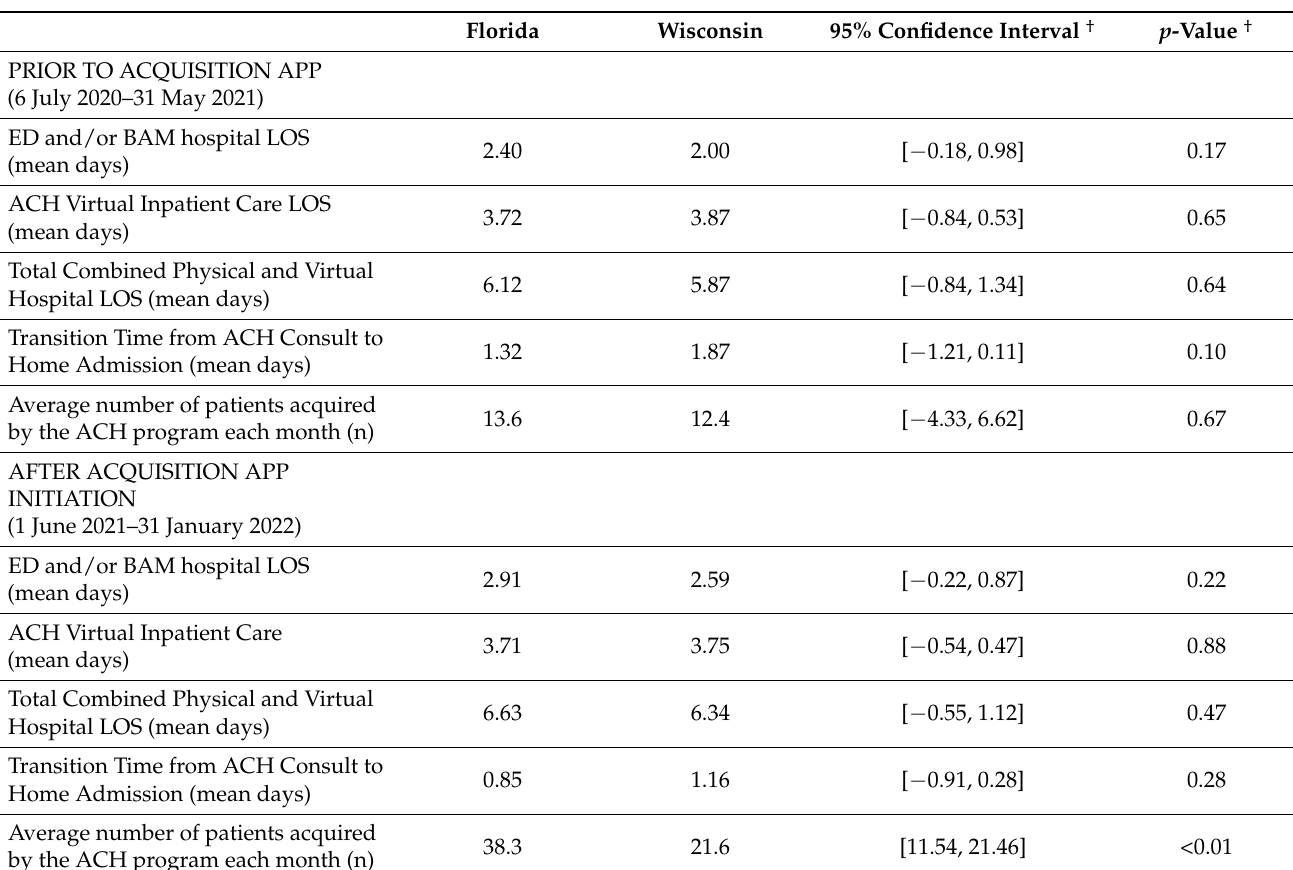
Table 2. Comparison of ALOS and Patient Volumes between Florida and Wisconsin Pre and Post Florida